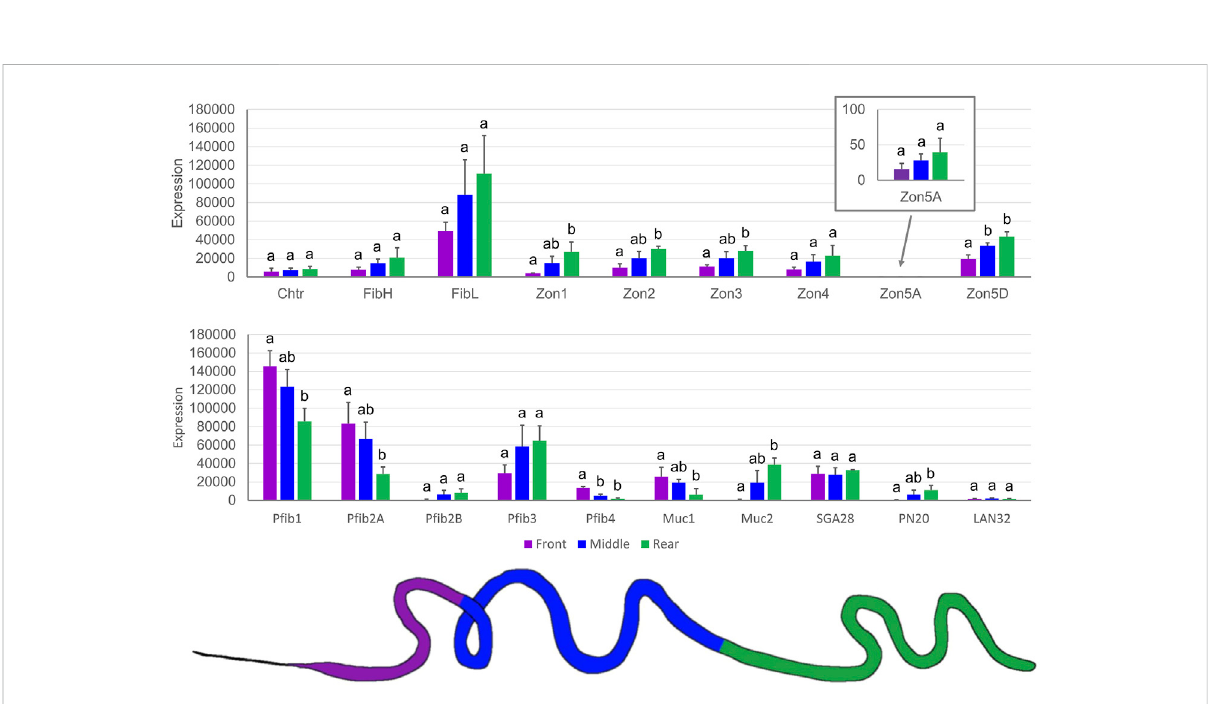
FIGURE 6 Expression of candidate genes in three parts of the SG measured by qPCR. The color-labeled parts of the SG are shown under the chart. The scale is linear; error bars show standard deviation; there were three biological replicates, and statistically signi fi cant differences (One way ANOVA + Tukey HSD test) are represented by different